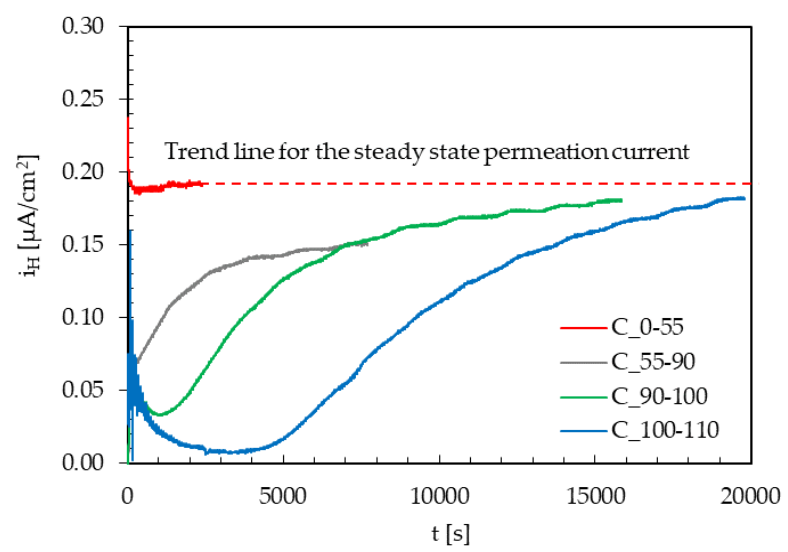
Figure 9. Effect of instant variations of the maximum load (amplitude = ± 10% TYS; frequency = 10 − 2 Hz) on the steady state hydrogen permeation current (i H, ∞ ).